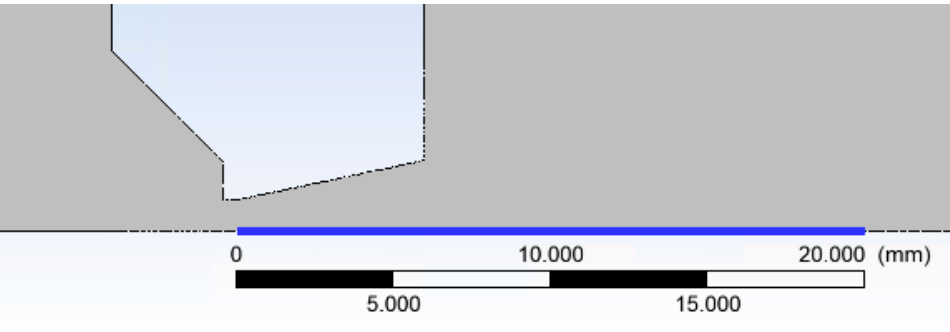
Figure 3. Cross-section through the experimental chamber in the aperture area (detail).